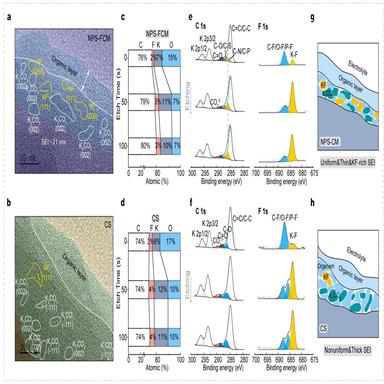
SEI morphology and chemistry investigation. HR-TEM images of the a) NPS-FCM and b) CS material after the initial discharge process at 0.05 A g− 1 , and corresponding XPS etching results: c–d) the atomic fractions of C, F, K, and O elements of cycled electrode materials; e–f) corresponding high-resolution C 1s and F 1s XPS scans. Schemes of g) NPS-FCM-induced uniform, thin, and KF-rich SEI and h) CM-induced nonuniform, and thick SEI.